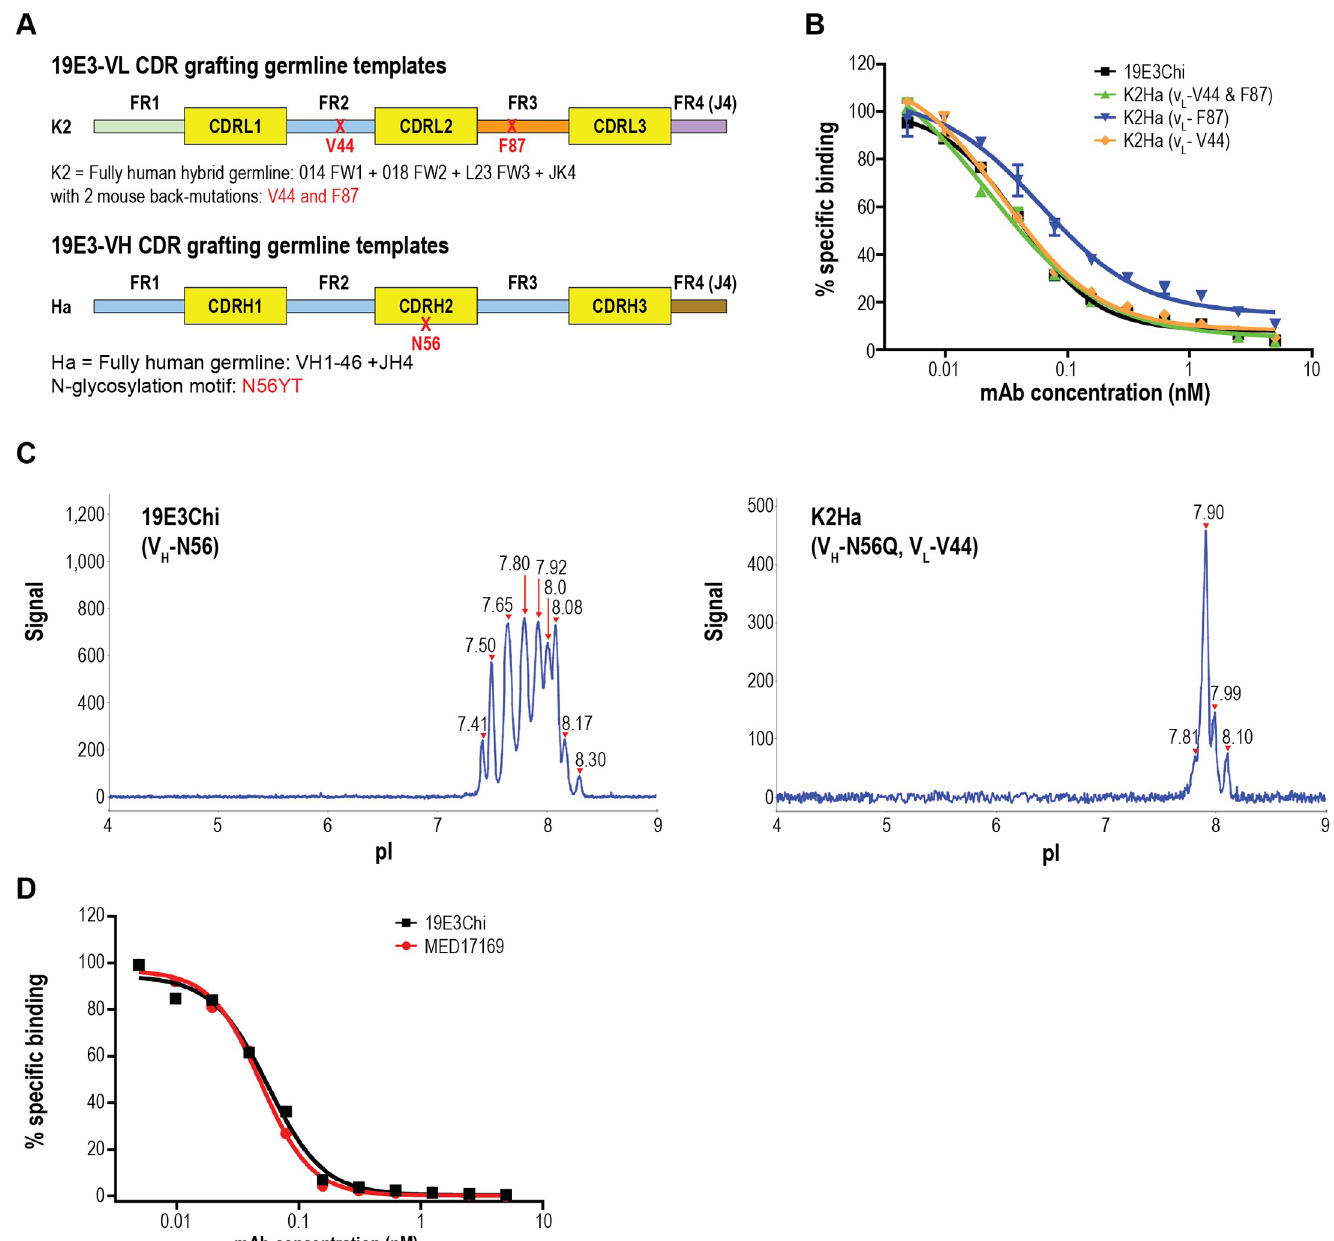
Fig 6. Humanization and engineering of hybridoma clone 19E3. (A) Humanization design strategy: K2 light-chain acceptor framework template combined different human germline FRs and encoded 2 back-mutated murine residues (V44 and F87) illustrated by the 2-red x’s. Ha heavy-chain acceptor framework template designed from one human germline. An N-glycosylation site in the V H -CDR2 is shown. FRs from different germlines are highlighted with contrasting color blocks. (B) Humanized clones screened by HTRF epitope competition assay: Unlabeled humanized variants competed with europium cryptate–labeled chimeric mAb 19E3 for binding to biotinylated IL-21. Unlabeled 19E3Chi was used as control to demonstrate 100% binding. K2Ha (V L -V44 and F87), encoding two murine residues, and K2Ha (V L -V44) encoding only one murine residue both exhibited binding activity comparable to 19E3Chi. Encoding one murine residue K2Ha (V L -F87) resulted in decreased binding activity. (C) Mitigation of N-glycosylation site: NanoPro cIEF electropherogram of 19E3Chi with V H -N56 glycosylation site and K2Ha (V L -V44) with the glycosylation site removed (V H -N56Q). Multiple peaks indicate more charge heterogeneity. Charge isoforms were aligned through calibration of the internal fluorescence pI markers. (D) HTRF epitope competition assay. The final humanized lead mAb, MEDI7169, demonstrated the same binding activity as 19E3Chi.